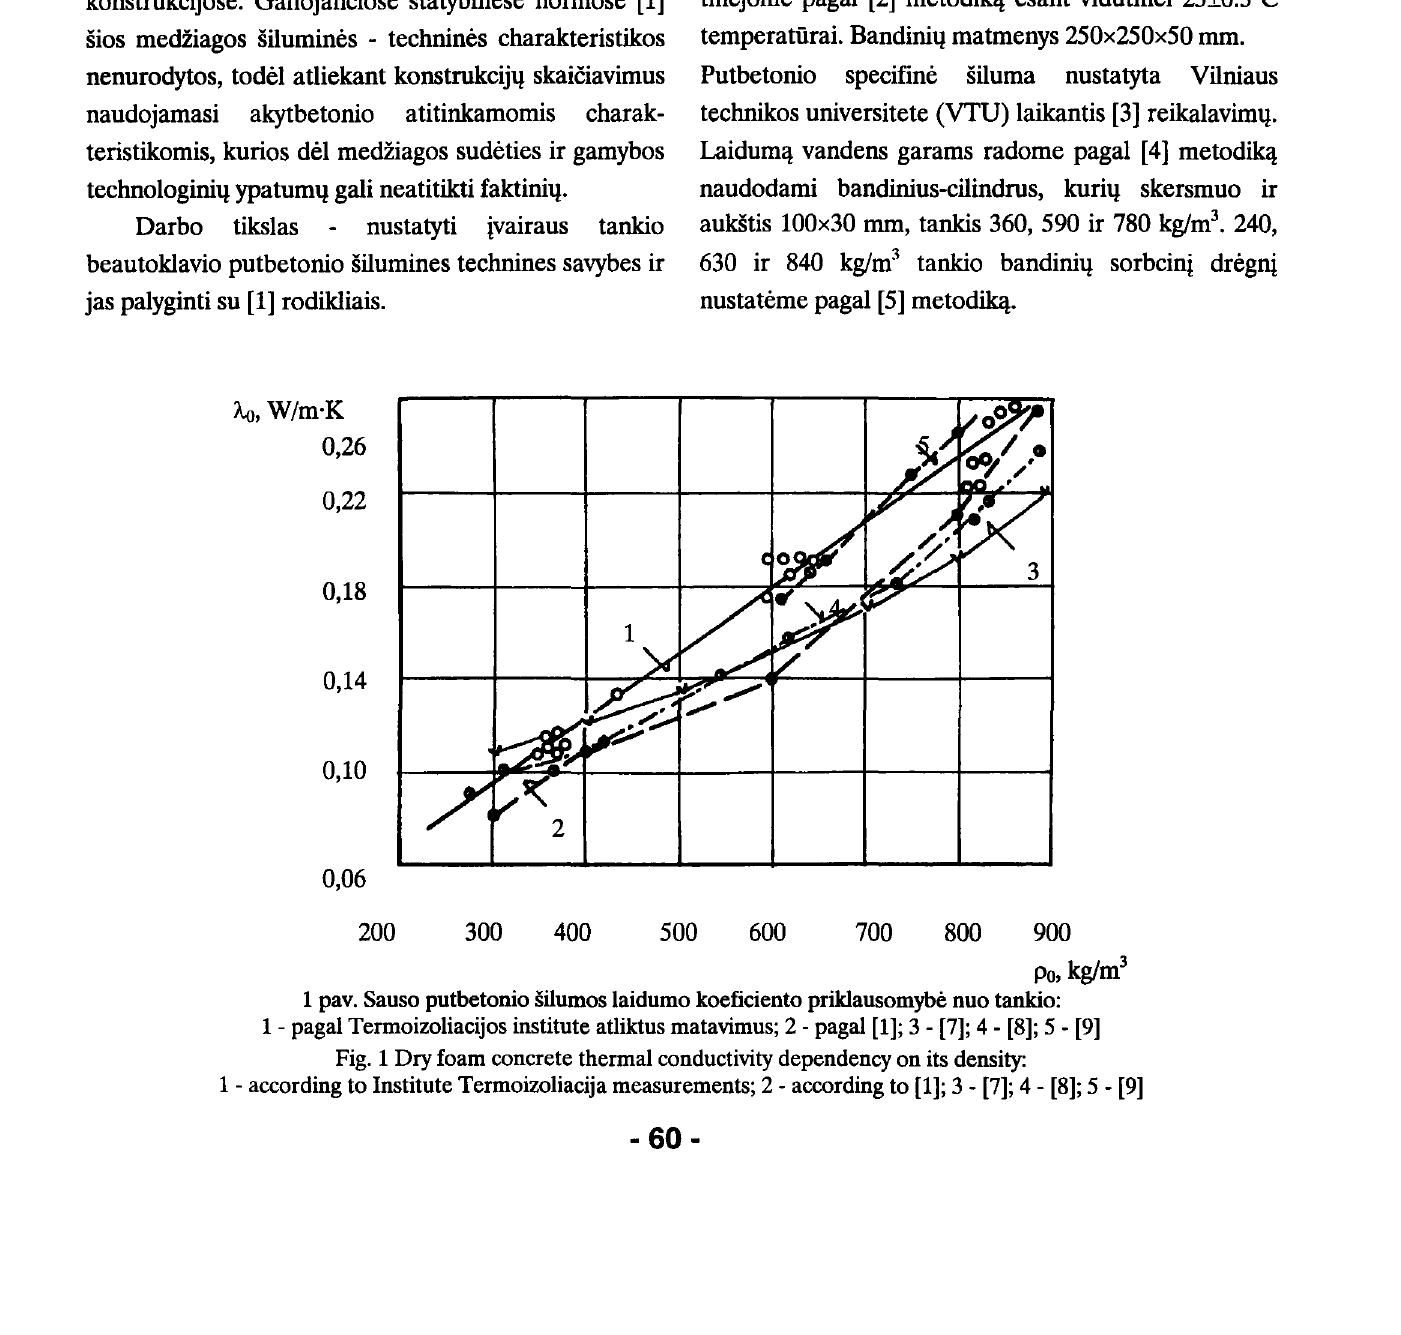
Fig. 1 Dry foam concrete thermal conductivity dependency on its